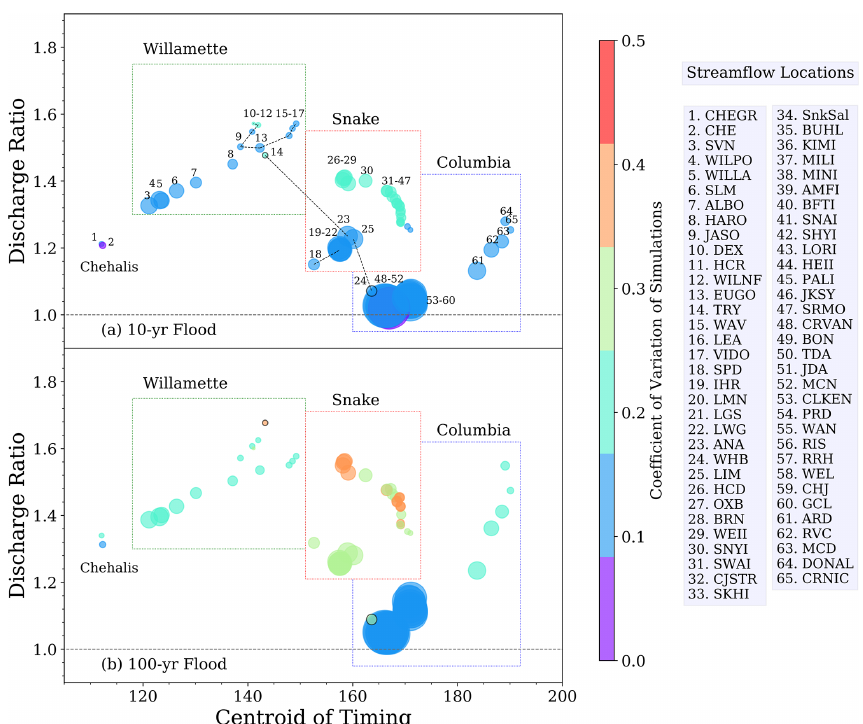
Figure 6. As in Fig. 5 but only for points on the indicated rivers. Dashed lines indicate tributaries: 9–12 are on the Middle Fork Willamette River, and 15–17 are on the McKenzie River; tributaries of the Snake River are the Grande Ronde (14), Clearwater (17), and Salmon (24) rivers. In (b) , the Grande Ronde and Salmon rivers are clearly distinguished by a black circle around their perimeter. Table 1 translates the codes in the legend into named locations and shows the numerical values represented in the figure. As is evident from both snow dominance and size, locations are ordered downstream to upstream from left to right for each